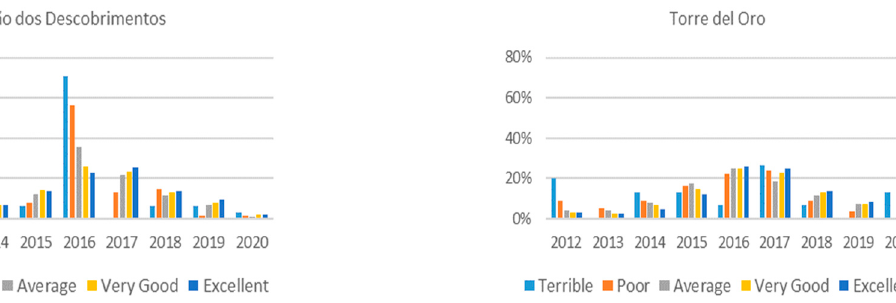
Figure 7. Rating values given on TripAdvisor for each case of the study.